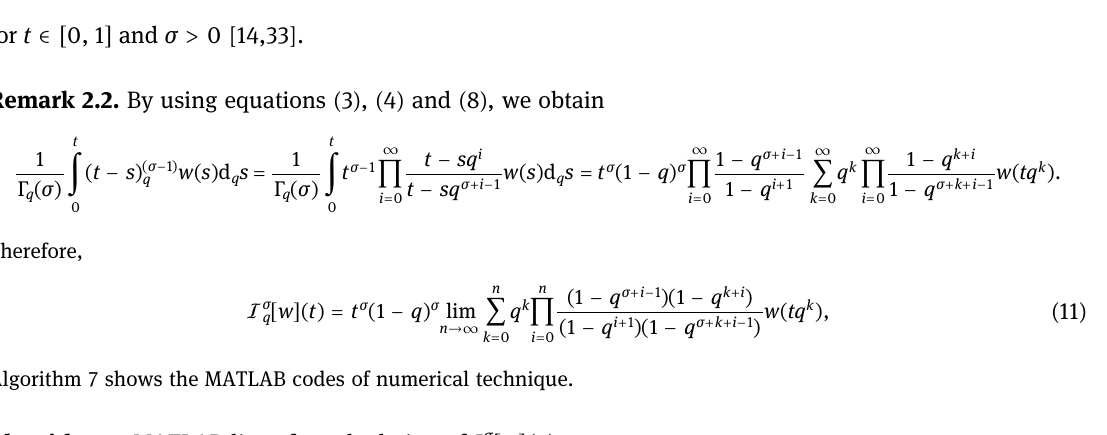
Algorithm 7. MATLAB lines for calculation